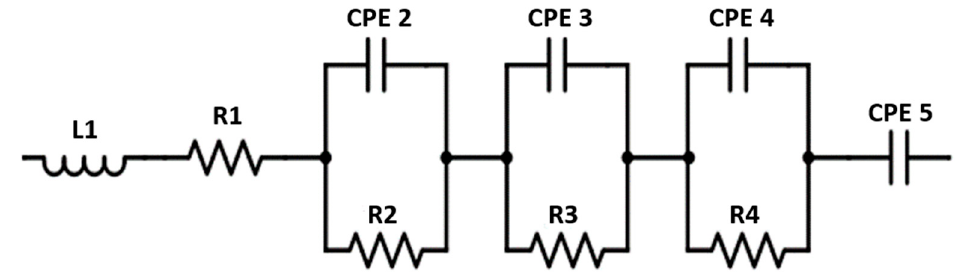
Figure 2. Equivalent circuit model used for EIS fit analysis.